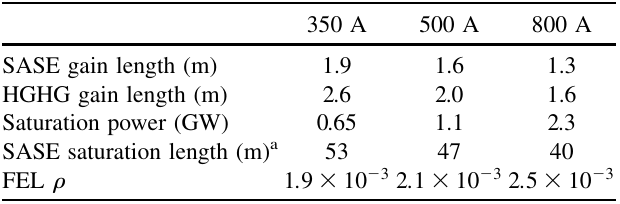
TABLE II. Calculated FEL parameters at 20 nm, gain length, saturation power, and saturation length using the Xie formula [25] with electron and undulator parameters used for our studies.